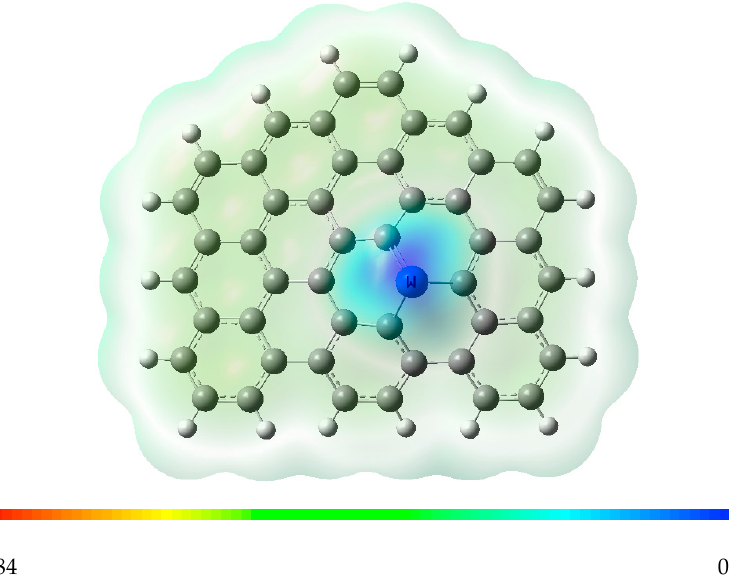
Figure 3. Molecular electrostatic potential (MEP) surface of W-SV-graphene.